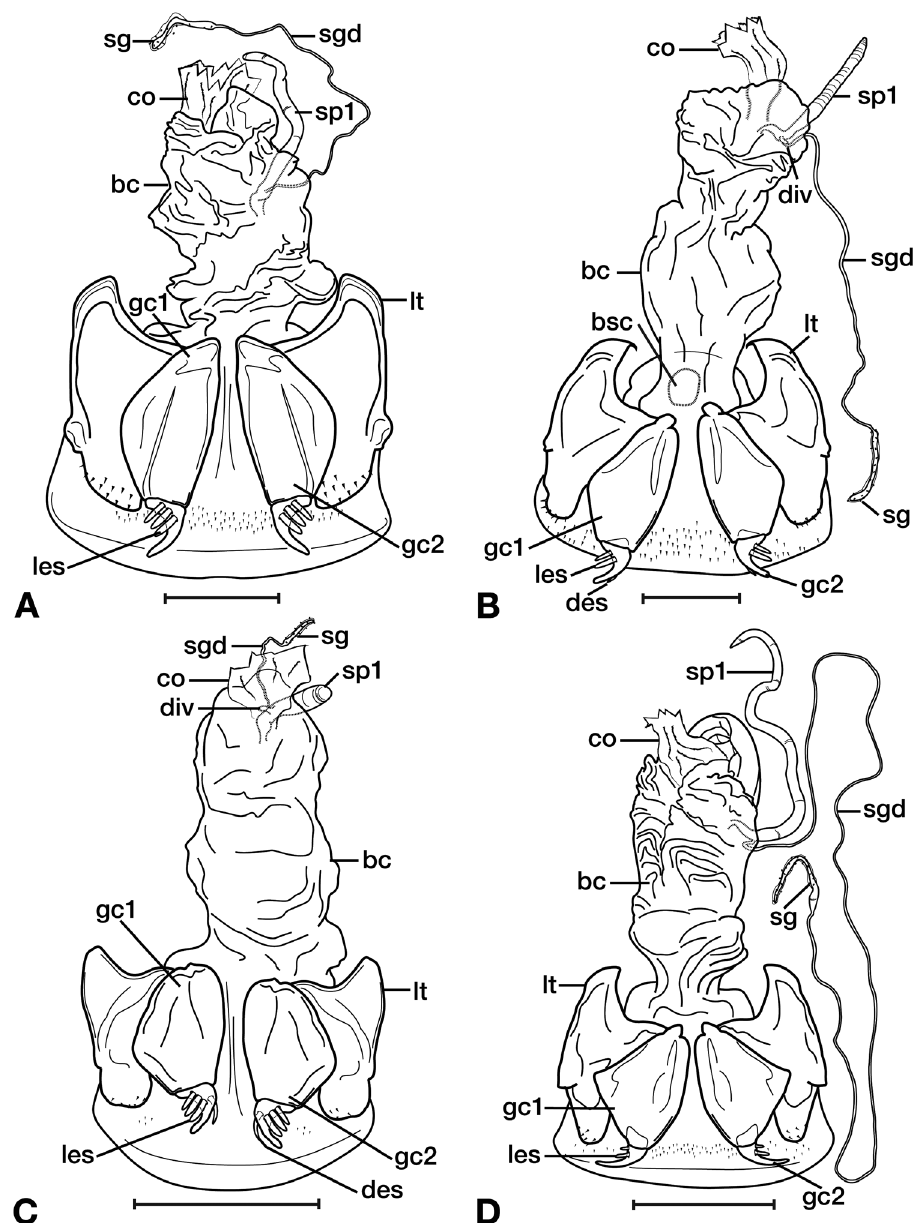
Figure 34. Line drawings of the female reproductive tract of species of the genus Catascopus Kirby, known from Taiwan, ventral aspect. A C. ( s. str. ) ignicinctus Bates B C. ( s. str. ) sauteri Dupuis C C. ( s. str. ) viridiorchis sp. n. D C. ( Catascopoides ) horni Jedlička. Legend: bc bursa copulatrix; bsc bursal sclerite; co common oviduct; des dorsal ensiform setae; div diverticulum; gc1 gonocoxite 1; gc2 gonocoxite 2; les lateral ensiform setae; lt lateral tergite; sg spermathecal gland; sgd spermathecal gland duct; sp1 sper- matheca 1. Scale bars: 1